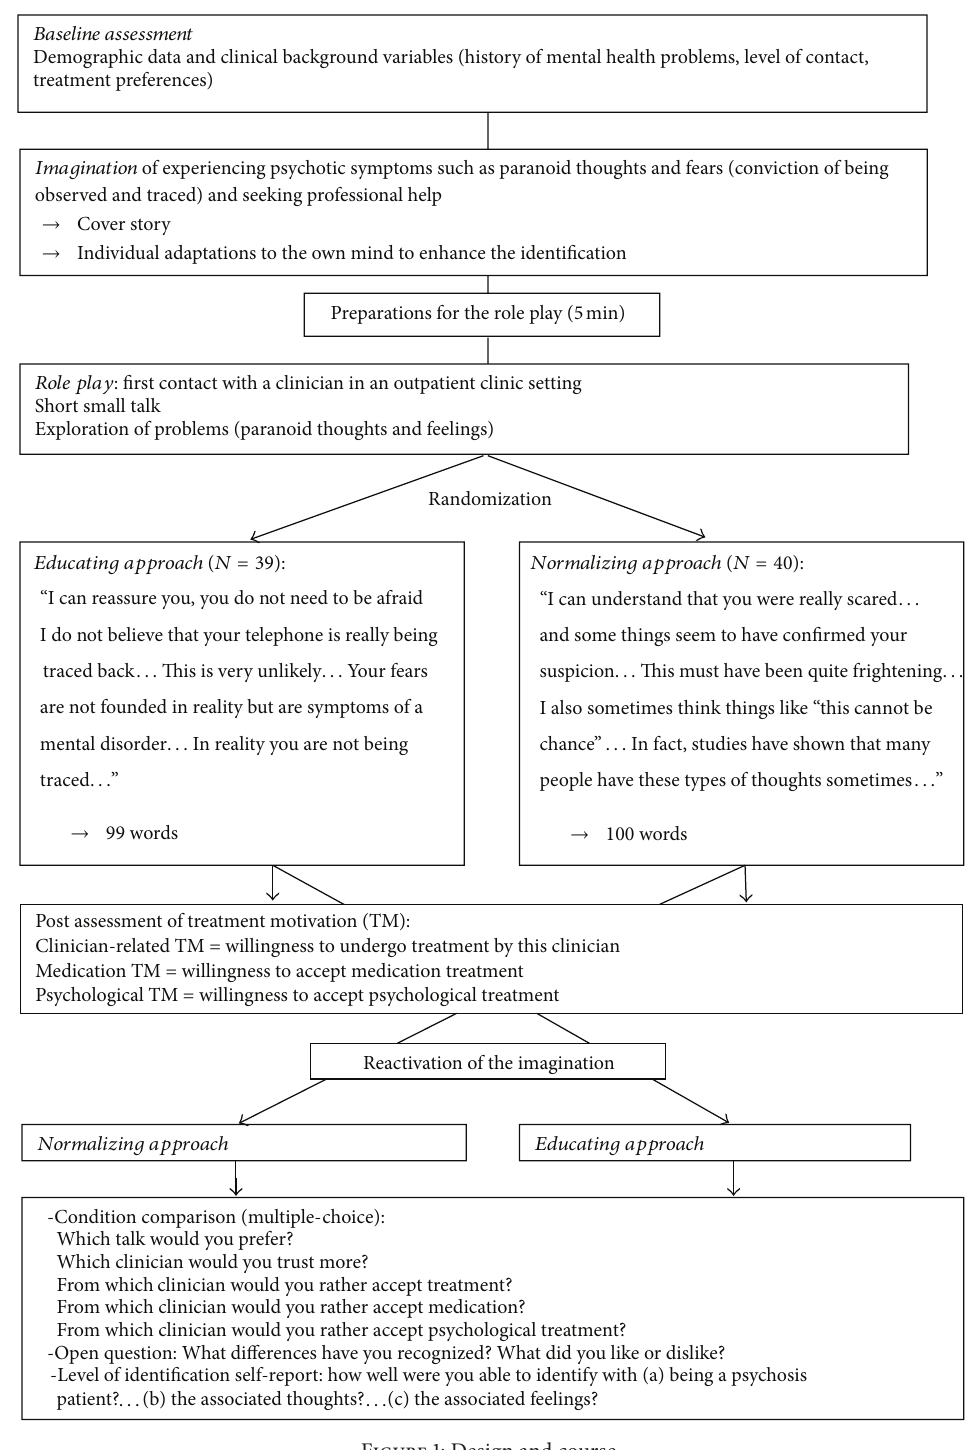
Figure 1: Design and